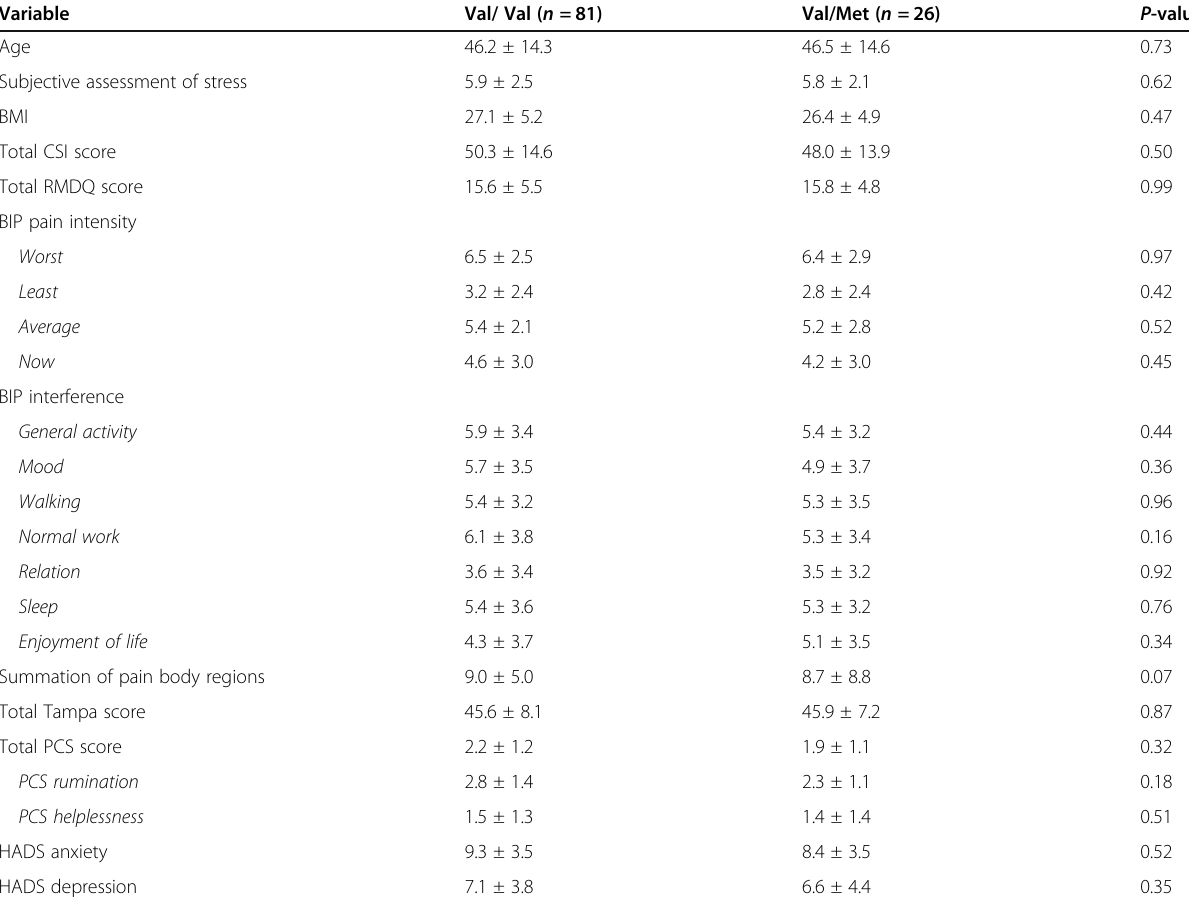
Table 2 Comparison of the quantitative variables according to the BDNF Val66Met genotypes